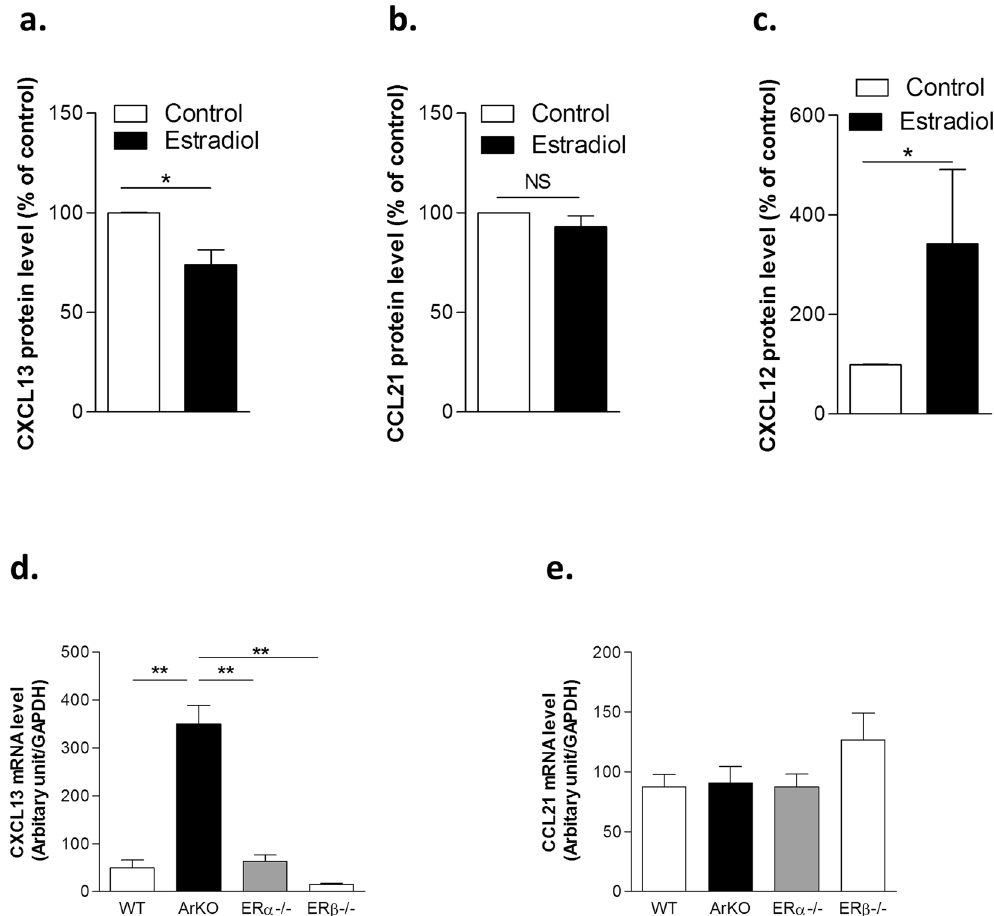
Figure 3. Modulation of chemokine expression in mouse thymuses and by β -estradiol in human primary cultured TECs. Human primary TECs were stimulated for 24 hours in the presence of 17- β estradiol (10 − 8 M). Effects of estradiol on CXCL13 ( a ), CCL21 ( b ) and CXCL12 ( c ) protein expression by cultured primary human TECs. mRNA expression levels of CXCL13 ( d ) and CCL21 ( e ) in thymuses of C57Bl6J, aromatase knock-out (ArKO), estrogen receptor α KO (ER α− / − ) and estrogen receptor β KO (ER β− / − ) female mice. Results are the mean values ± SEM. n = 5 different TEC supernatants for protein analysis and n > 3 different mouse thymuses per strain. P values were obtained using the Wilcoxon test for ( a to c ); P values were obtained using the Student t test for ( d , e